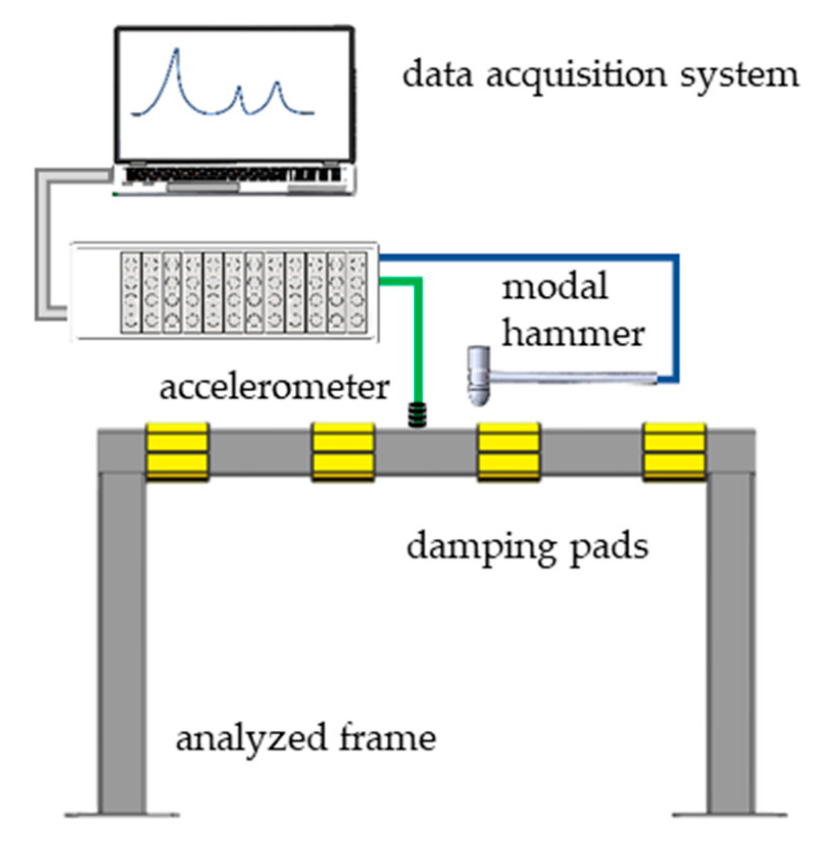
Figure 2. Experimental setup used in impact testing.